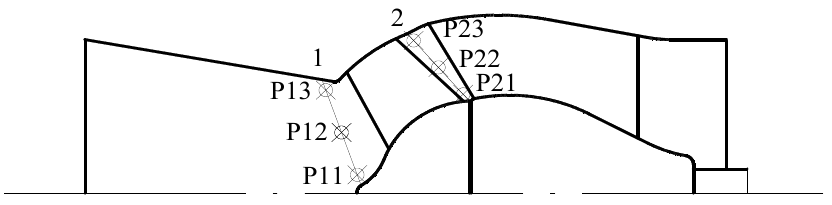
Figure 11. Layout of the monitoring points.